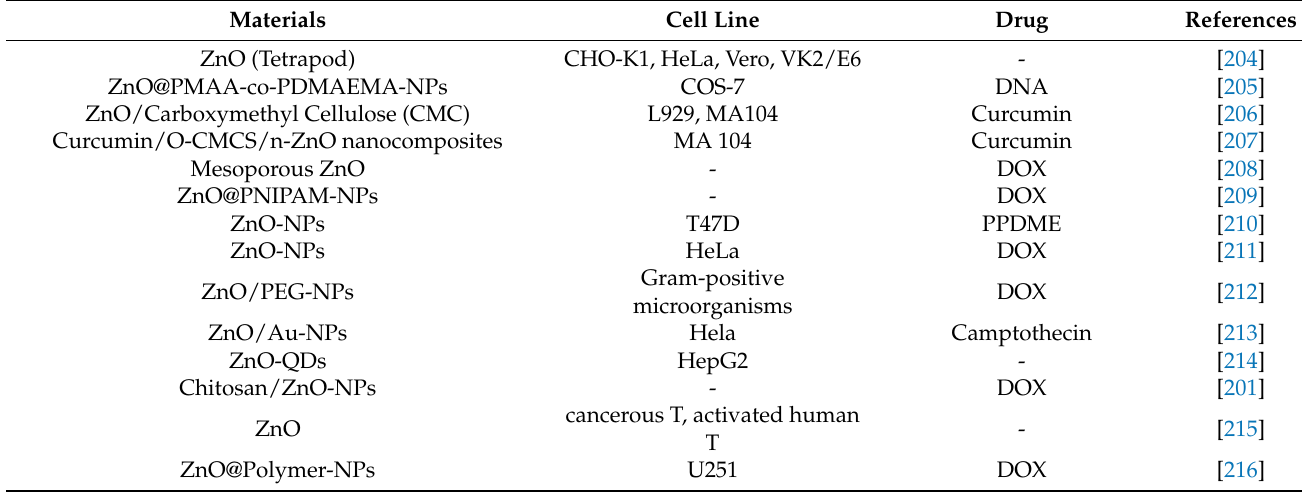
Table 8. ZnO-NPs-based drug delivery